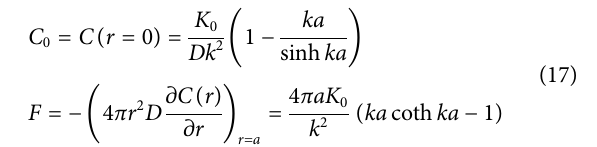
Frontiers in Materials |